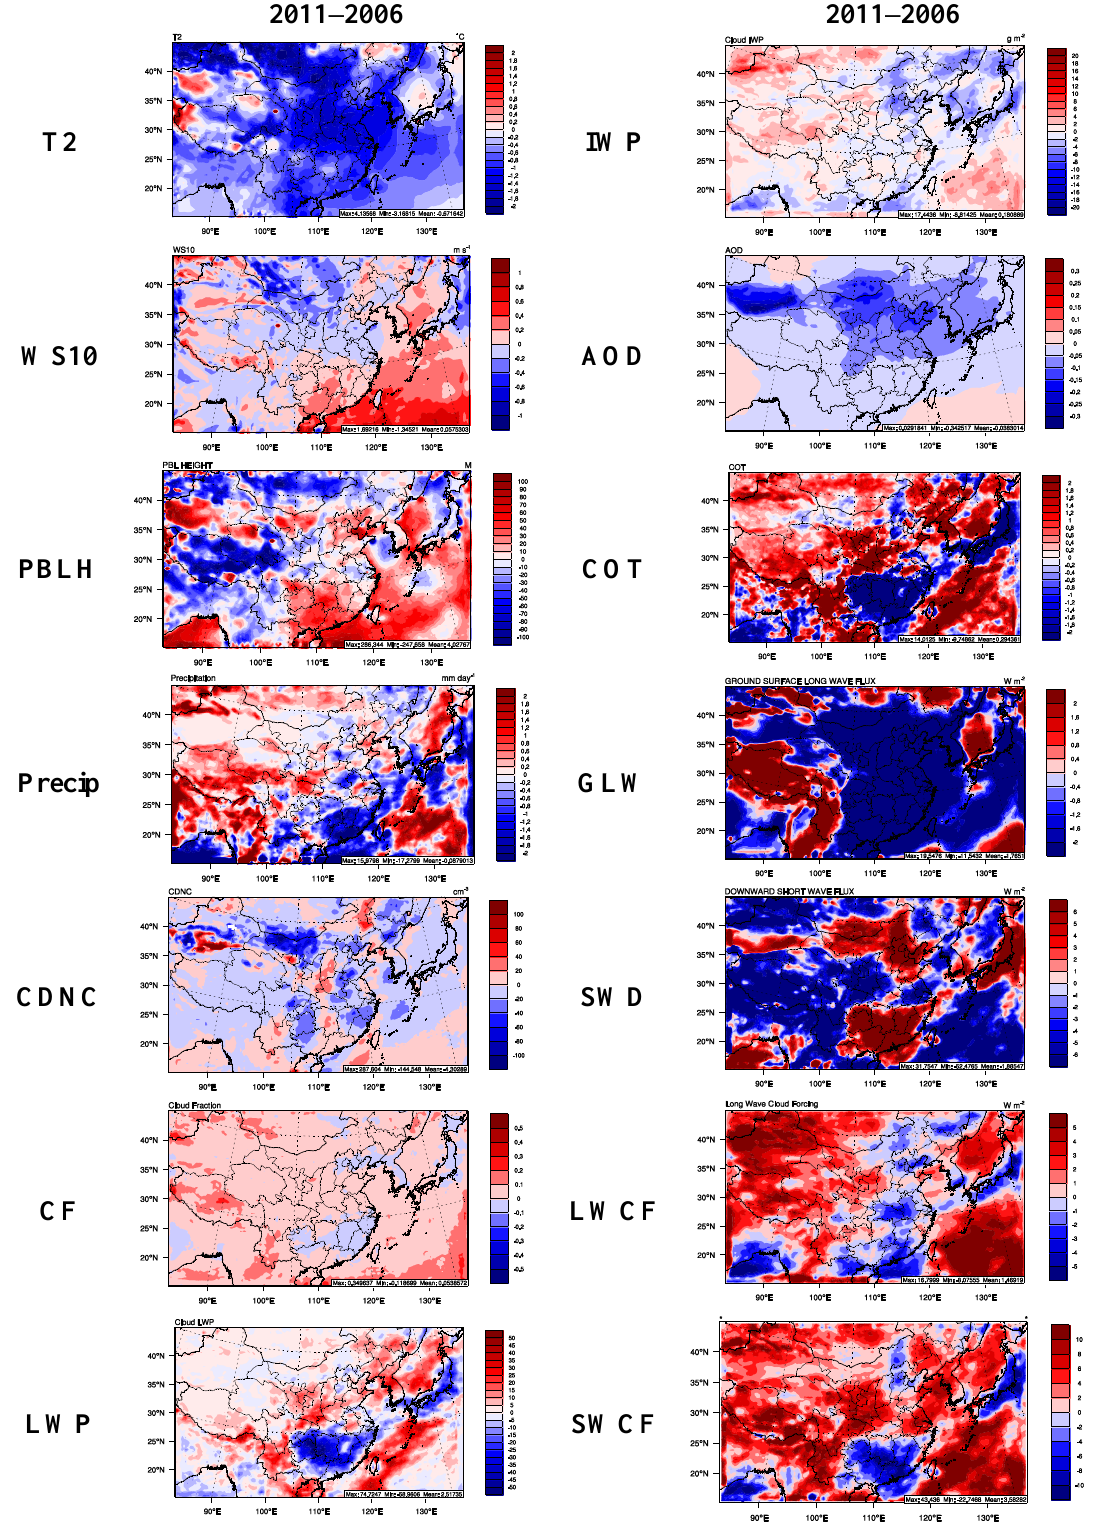
Figure 9. Annual mean absolute differences in meteorological, radiative, and cloud variables between 2011 and